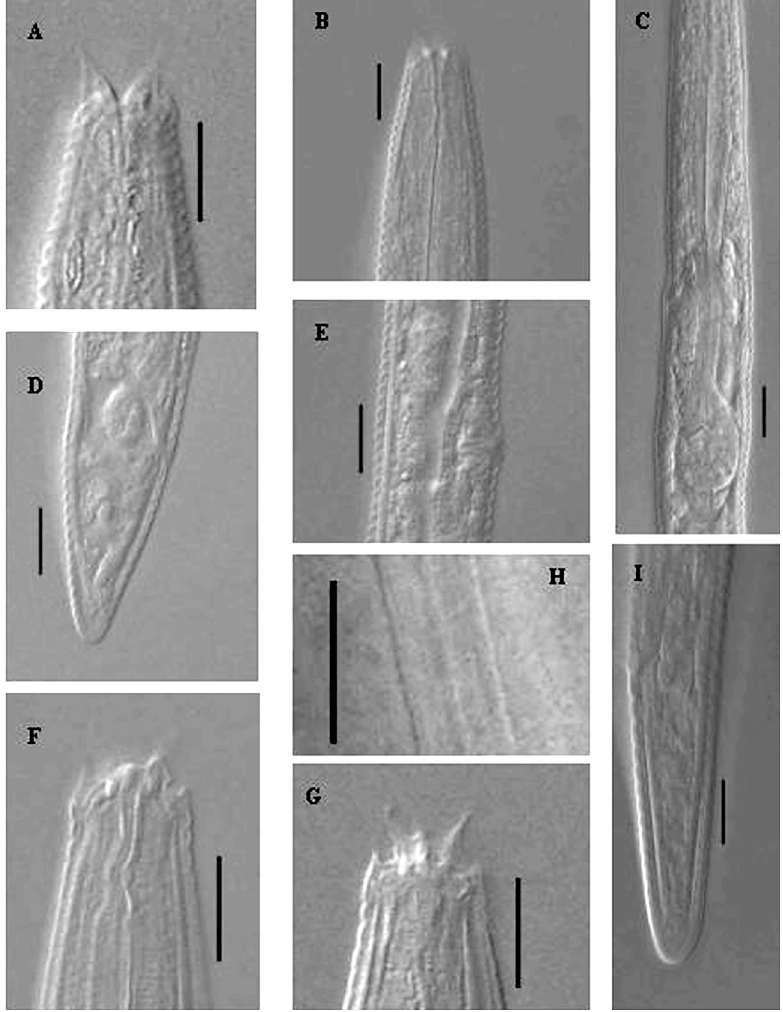
Figure 2. Acrobeloides nanus (A-E), Chiloplacus demani (F-I). A - Lip region; B - Buccal cavity; C - Pharynx; D - Tail; E - Vulval region; F - Buccal cavity; G - Lip region; H - Lateral lines; I - Tail. (Scale =